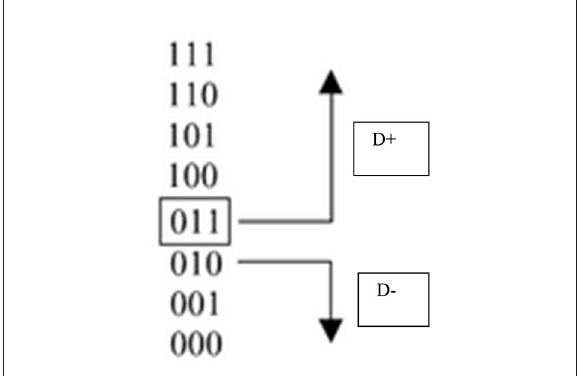
FIGURE7 An example of splitting profile characterizing a fast-and-frugal tree for classifying items into two complementary categories based on three cues (extracted from Martignon et al., 2003).